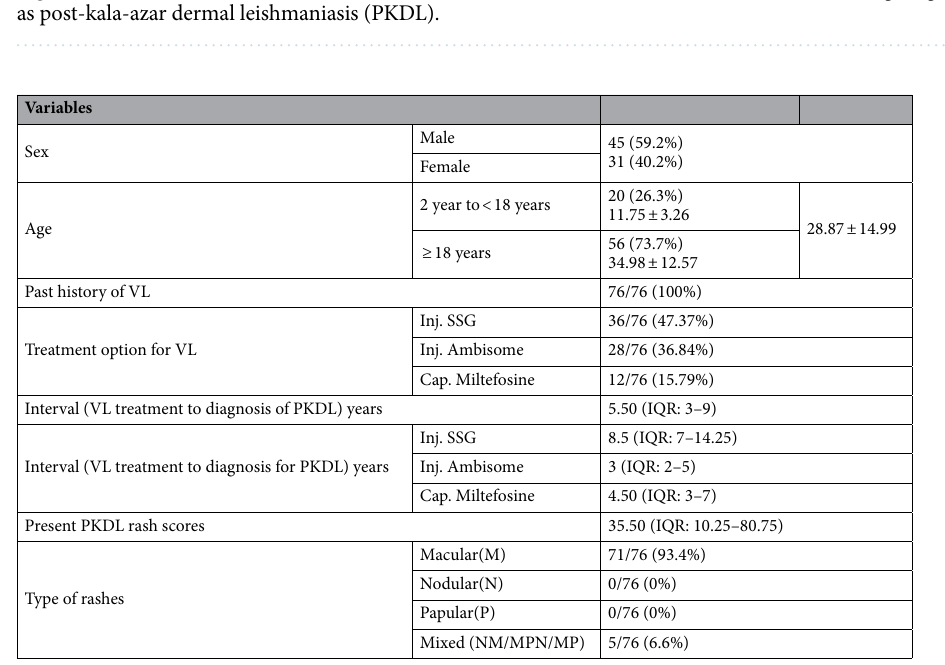
Table 1. Demographic and clinical parameters of all of the PKDL cases enrolled in the